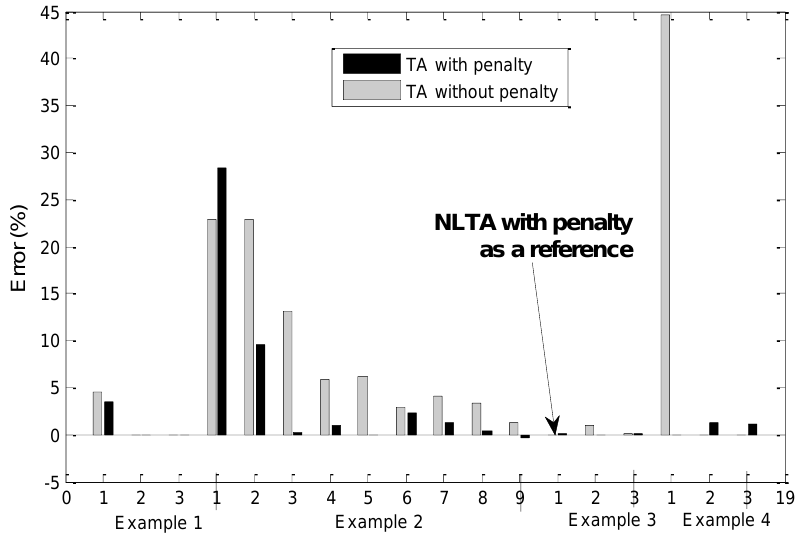
Figure 6. Comparing threshold algorithm with and without penalty in case of multi-state